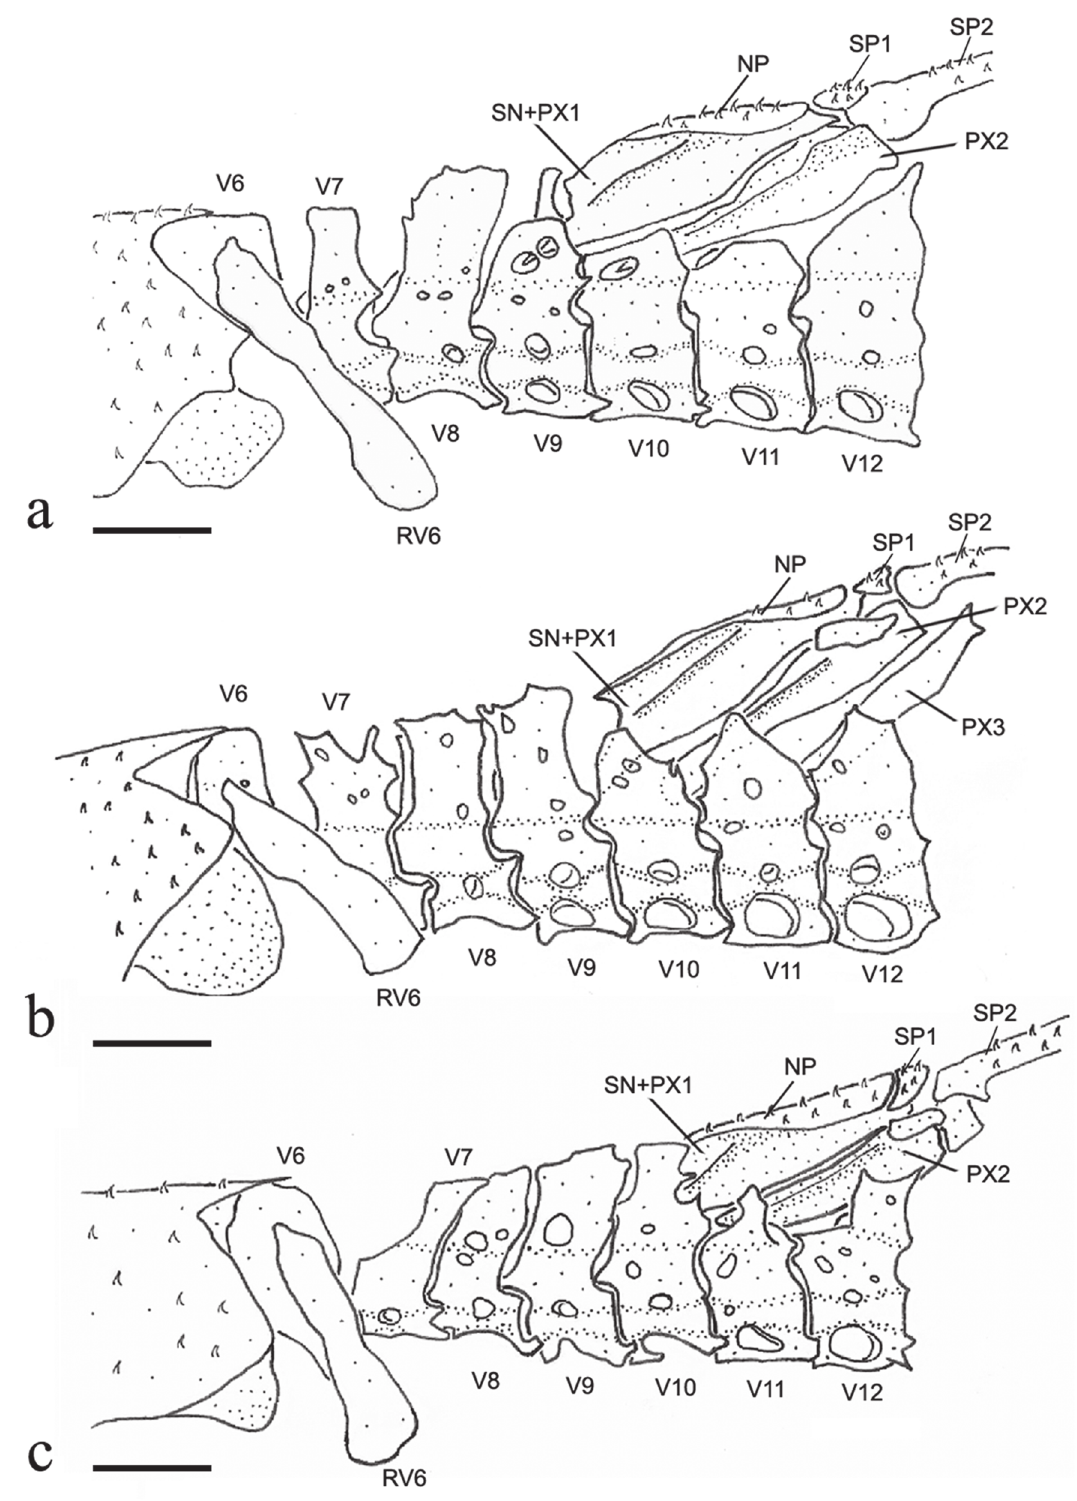
Fig. 1. Anterior portion of axial skeleton and dorsal-fin supports (left side, lateral view). a ) Rhinolekos britskii , DZSJRP 6489, 28.0 mm SL. b ) Rhinolekos garavelloi , DZSJRP 10477, 30.4 mm SL. c ) Rhinolekos schaeferi , DZSJRP 12192, 36.5 mm SL. Scale bar = 1 mm. Vertebrae counts included five from the Weberian apparatus. RV6 = rib of sixth vertebra; PX2-3 = compound proximal and medial radial 2-3; SN+PX1 = compound supraneural first dorsal-fin proximal radial; SP1 = first dorsal-fin spinelet; SP2 = second dorsal-fin spine; V6-12 = vertebrae